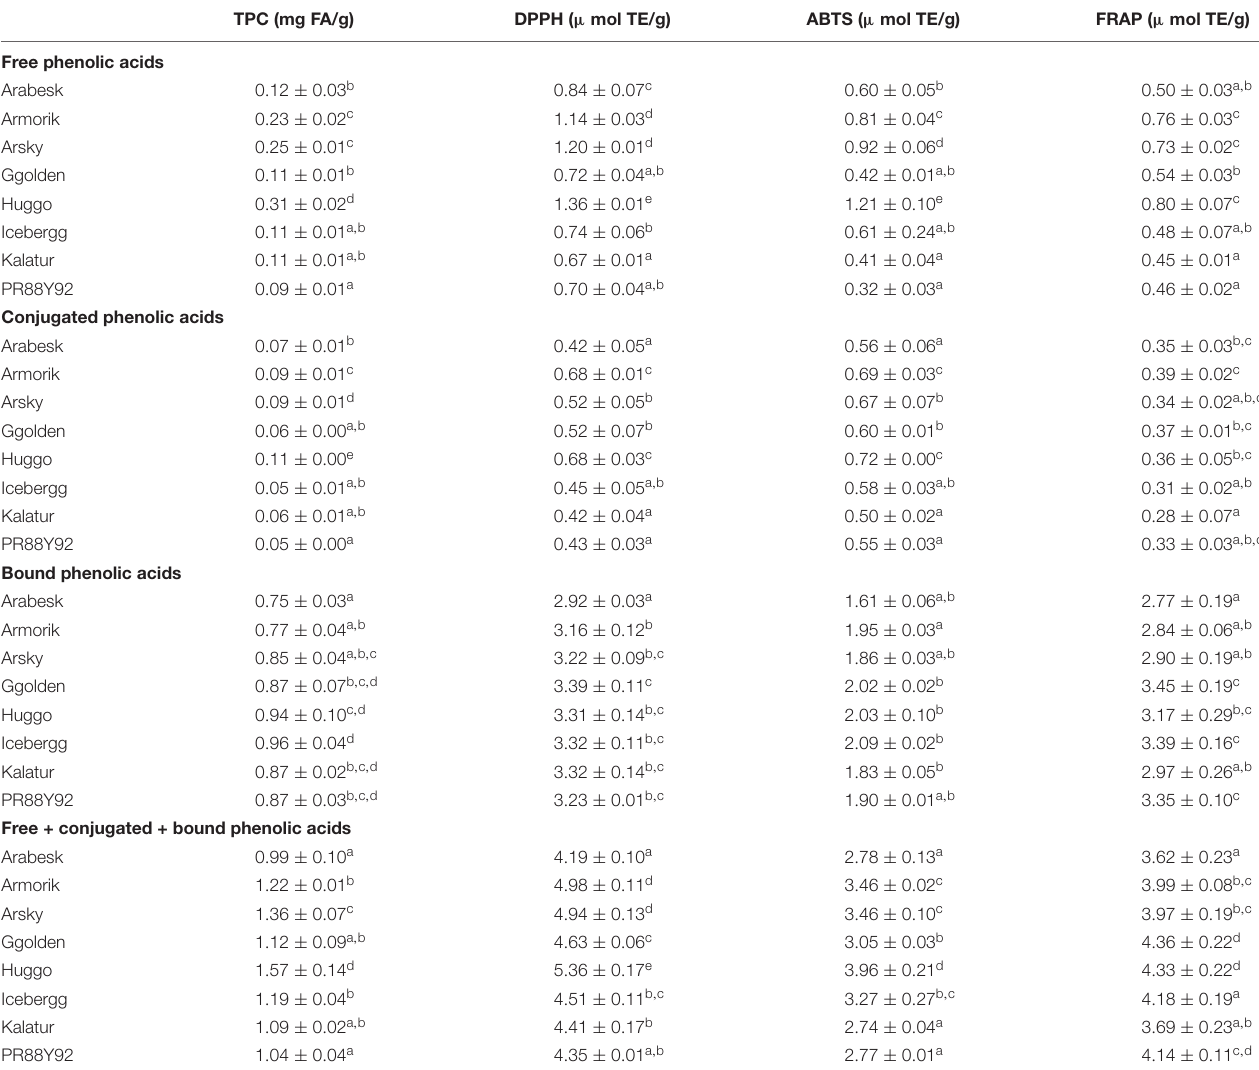
TABLE 7 | TPC and antioxidant activity of the free, conjugated and bound PA extracted from the eight varieties of sorghum and of the sum of the three fractions. TPC (mg FA/g) DPPH ( µ mol TE/g) ABTS ( µ mol TE/g)